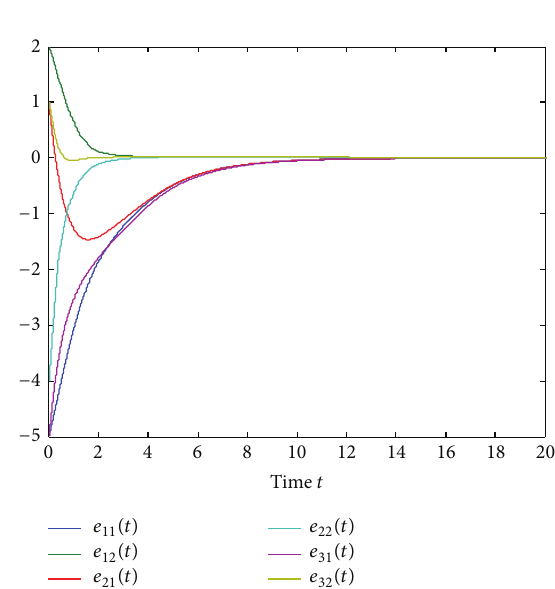
Figure 4: Random coupling delay 𝜏(𝑡) .